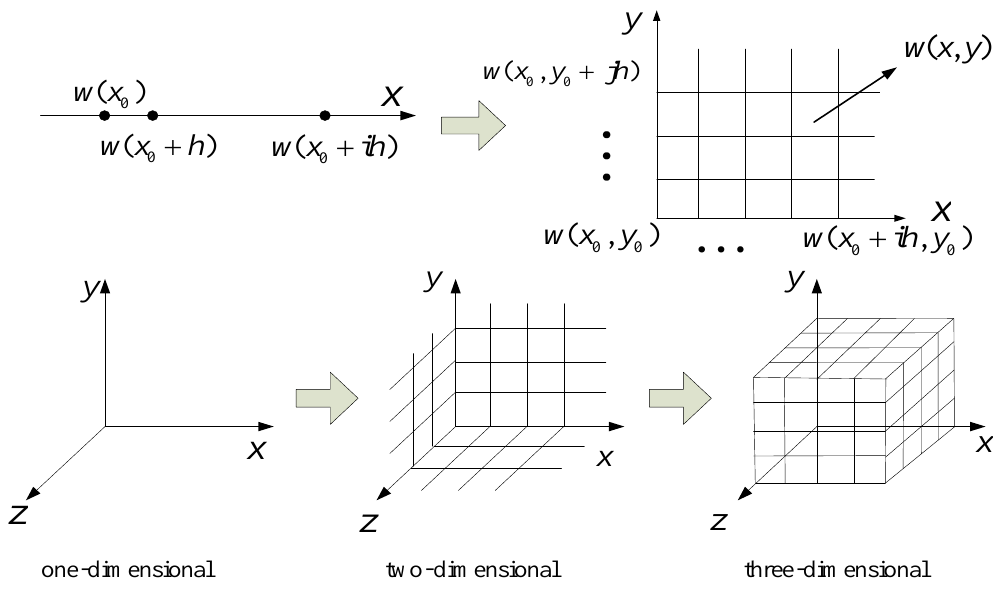
Figure 6. Construction process of three-dimensional atmospheric turbulence. Analogous to Equations (20) and (23), the three-dimensional turbulence recursion equation is formulated as